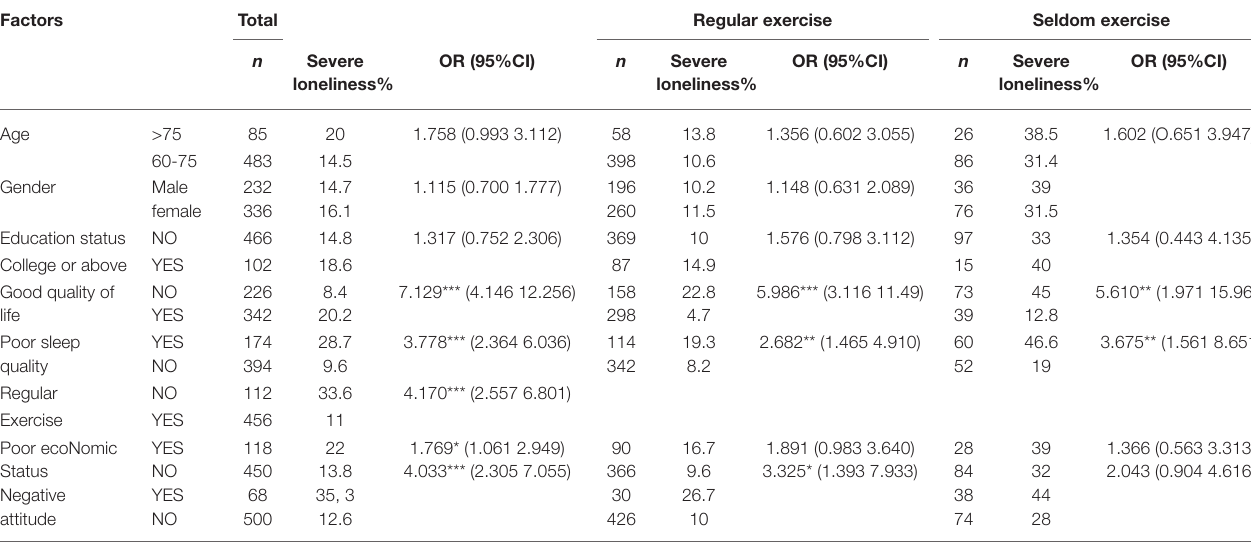
TABLE 2 | Univariate logistic regression analysis of related influencing factors of severe loneliness among the